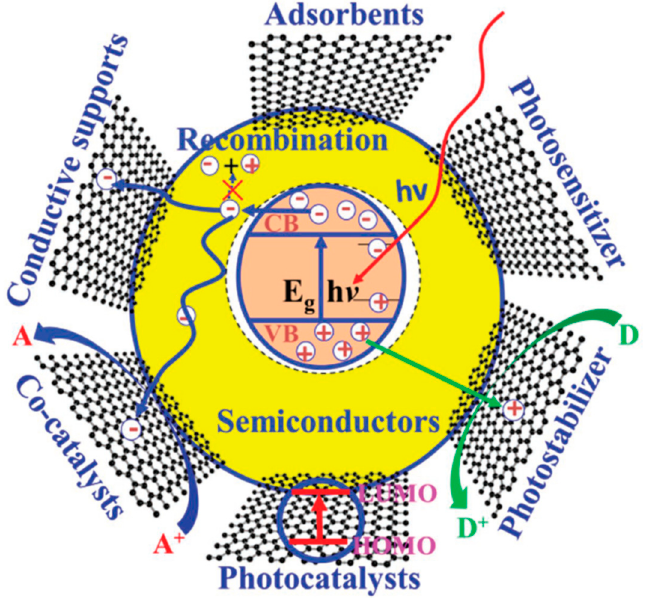
Figure 5. The crucial roles of graphene in the graphene-based composite photocatalysts. Reprinted by permission from John Wiley and Sons [29].